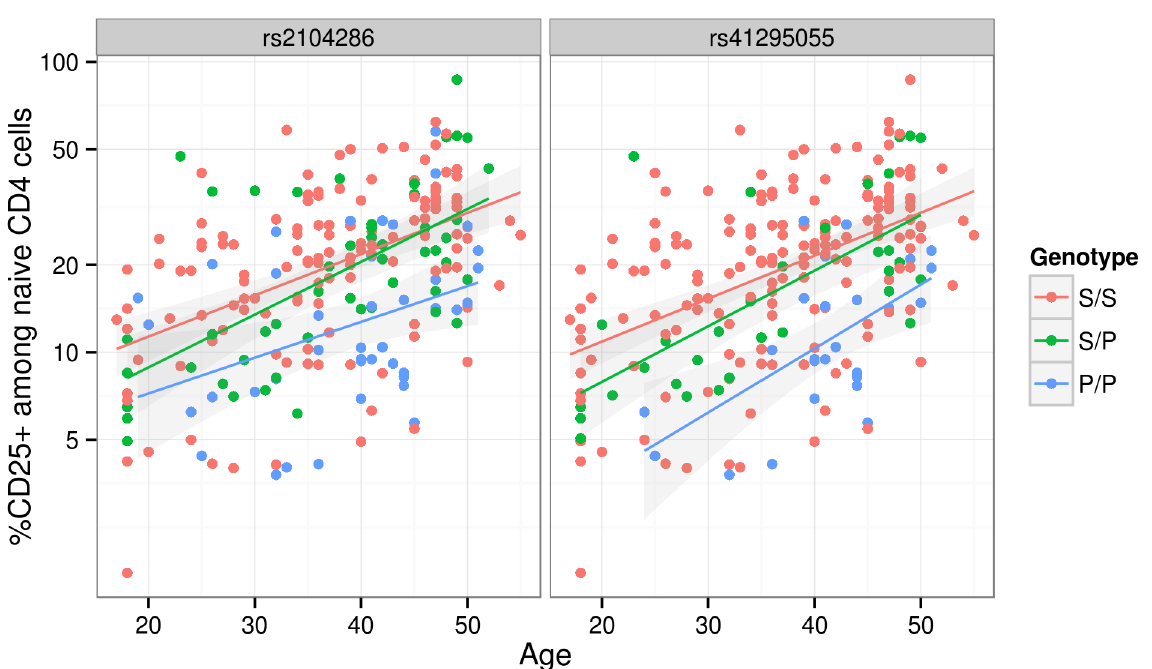
Fig 4. The proportion of naive CD4 + T cells that express CD25 (log scale) increases with age. The MS protective allele for the M2 SNP rs41295055: C > T associates with fewer CD4 + T cells expressing CD25 across all ages ( p = 3.45 × 10 − 8 ), and is statistically preferred to the previously reported M1